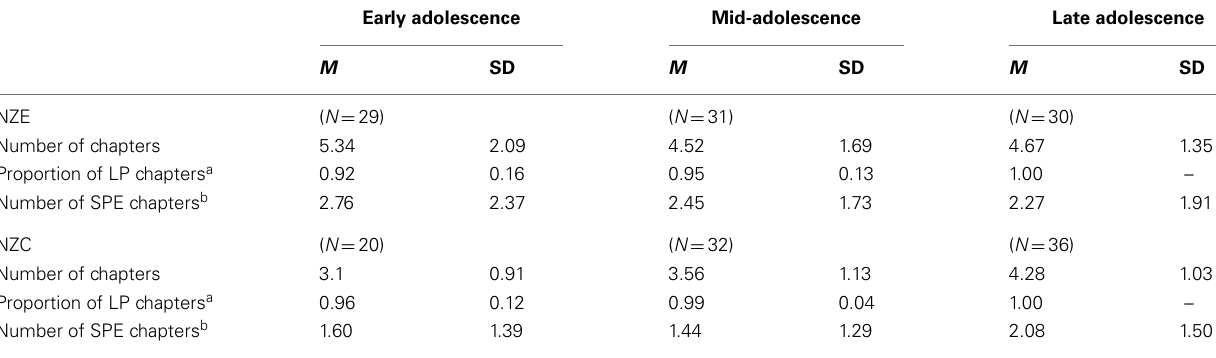
Table 2 | Number and types of life story chapters in early, mid, and late adolescence as a function of culture (Study